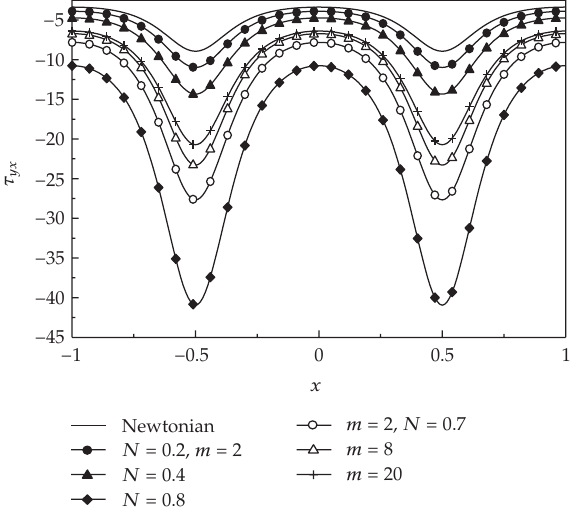
Figure 6: The shear stresses τ yx for α (cid:8) 0 . 5 , θ (cid:8) 1 . 2 , H (cid:8) 3, and di ff erent values of m and N